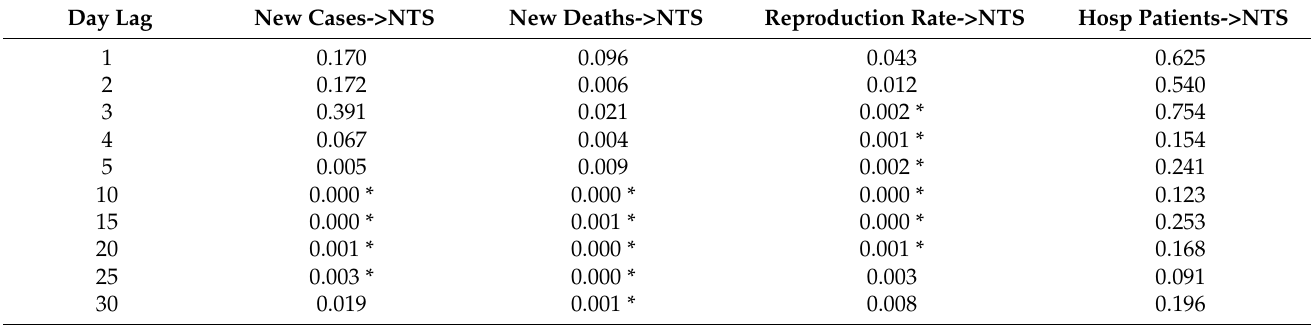
Table A10. Intensity variables, Granger-cause New_tests_smoothed (NTS), and p -values in day lags in